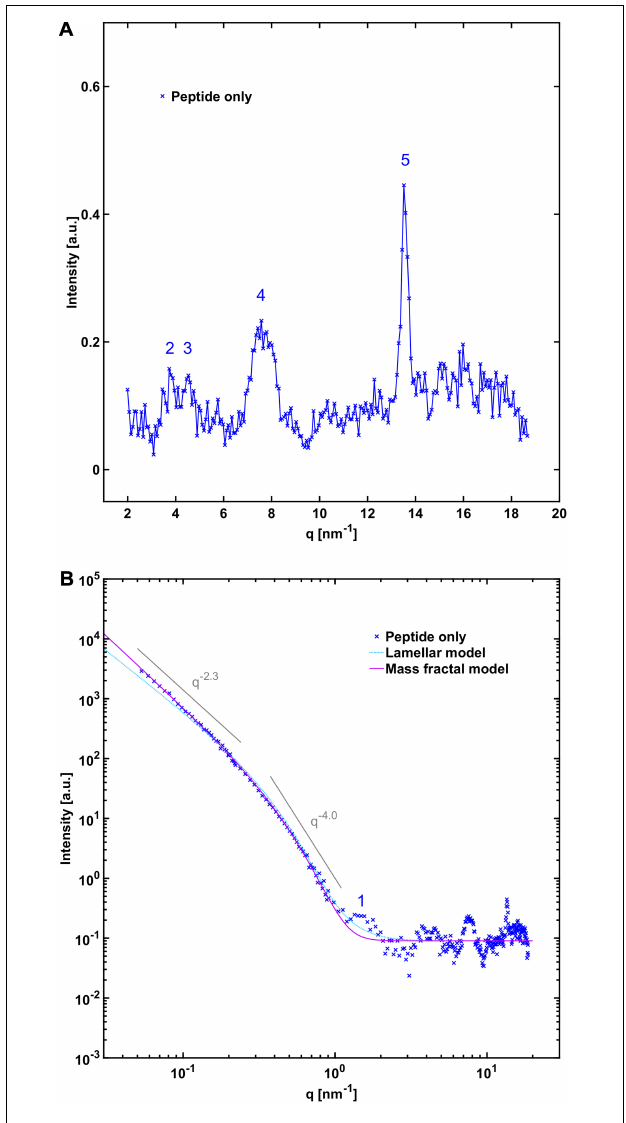
FIGURE 3 | (A) WAXS and (B) SAXS profile of NACore fibrillated in the absence of phospholipids. The numbers denote crystal diffraction peaks corresponding to miller indices of 1 = [2, 0, 0], 2 = [2, 0, –1], 3 = [2, 0, 1], 4 = ([2, 0, –2], [0, 0, 2], [2, 0, 2]), and 5 = ([1, 1, –1], [1, 1, 1]) in the NACore crystal structure reported by Rodriguez et al. (PDB ID: 4RIL) (Rodriguez et al., 2015; Pallbo et al., 2019; see also Supplementary Figure 5 ). In (B) two theoretical fits are shown. One is an infinite lamellar model with a polydisperse average layer thickness of 6.5 nm (see Supplementary Table 1 for details). The other one is a mass fractal model with polydisperse average building block radius of 4.3 nm (see Supplementary Table 1